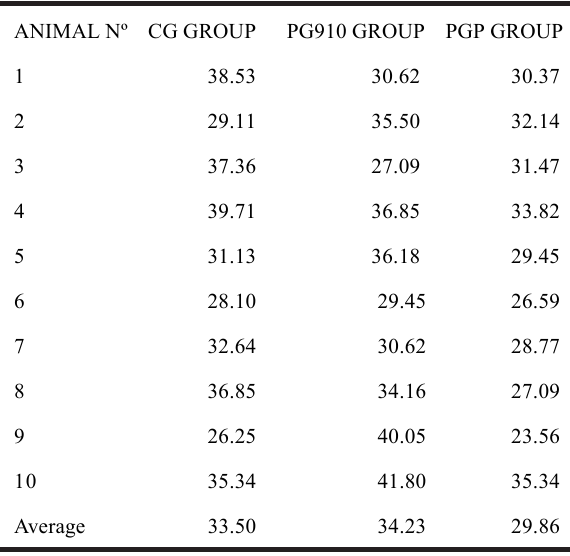
TABLE 1 –Abdominal wall tensile strength following laparotomy. Result of traction tests of the catgut, polyglactin and polyglecaprone